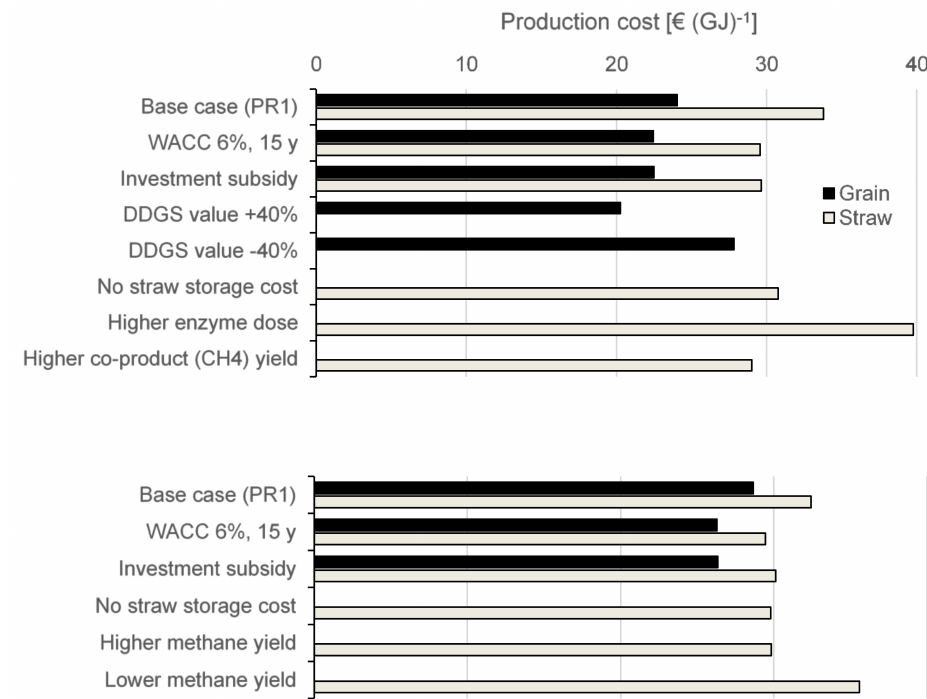
Figure 7. Results of the sensitivity analysis on the production costs for various ethanol ( above ) and biogas ( below ) production systems.